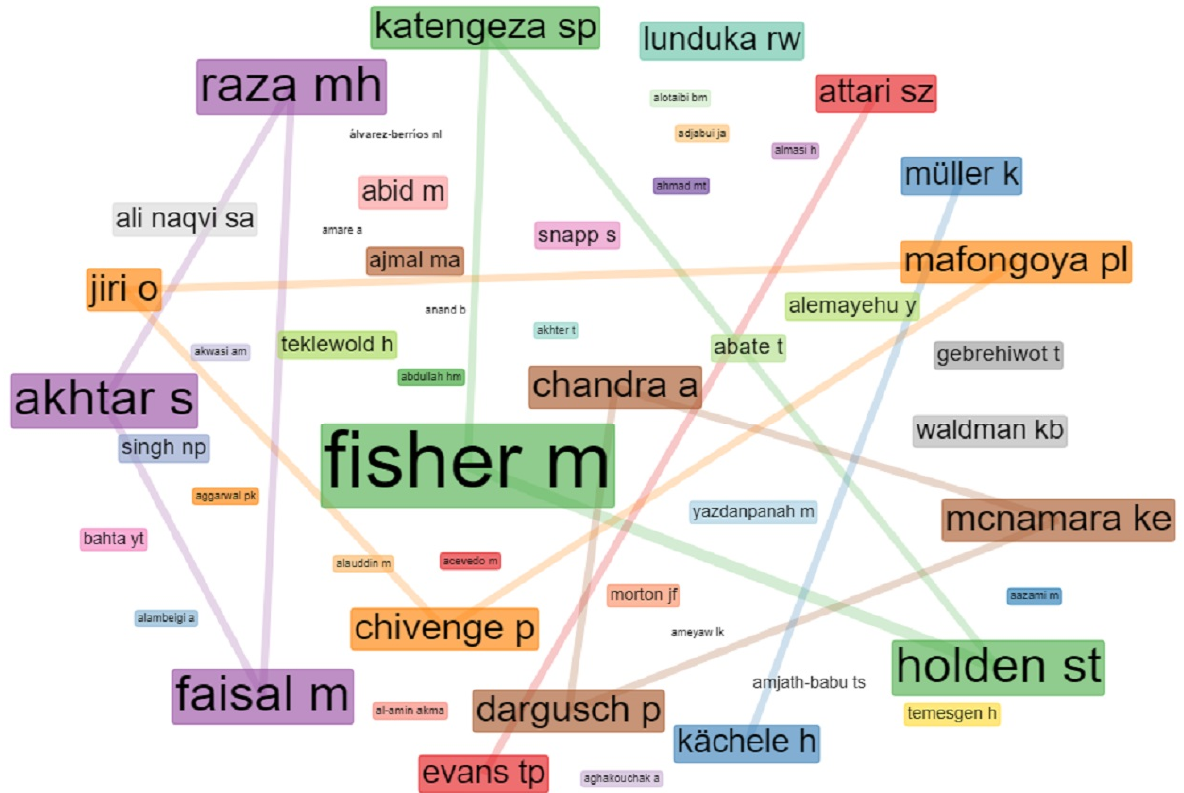
Figure 6. Collaboration network for the top 50 authors in PASSFDR studies indexed in Scopus from 2011 to 2020 .